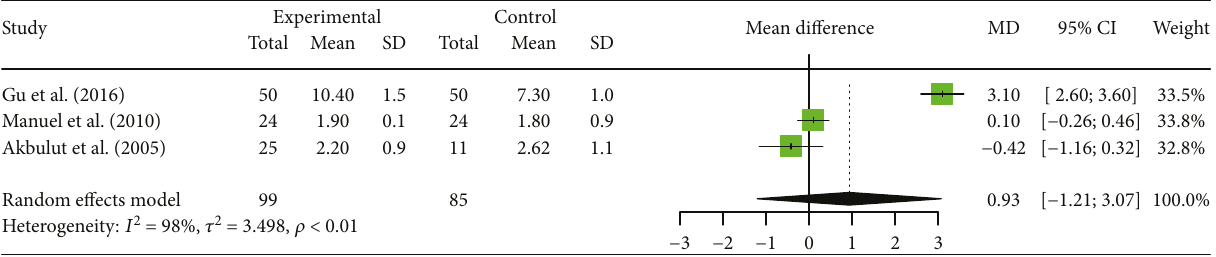
Figure 7: Forest plot of the changes of peripheral blood Th2 cell in human brucellosis patients compared with